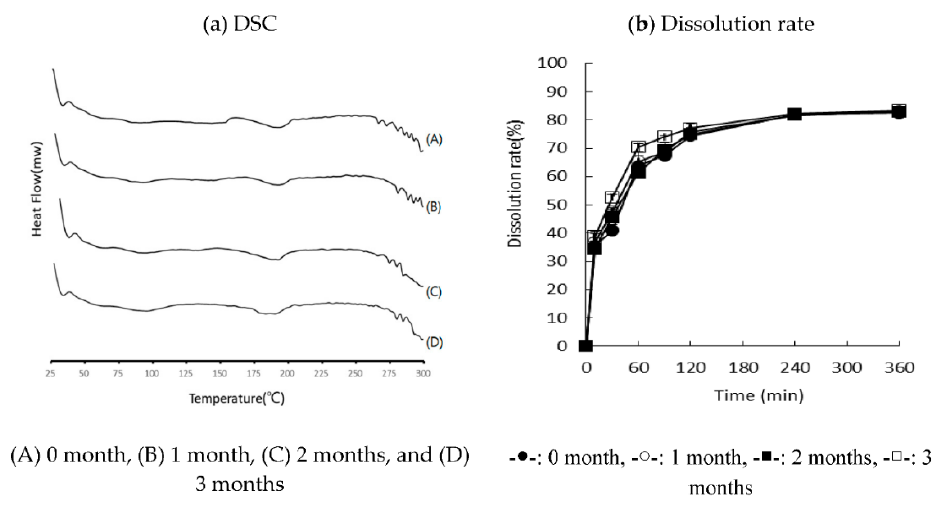
Figure 10. DSC and dissolution profile of optimized RXB-ASD for three months.